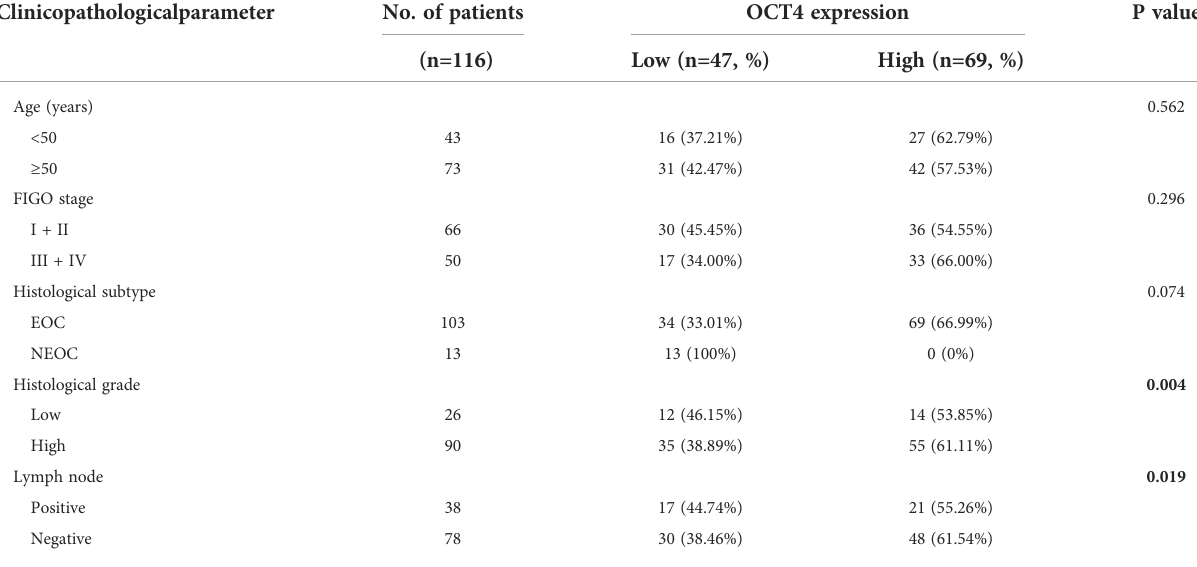
TABLE 1 Correlations between OCT4 expression and clinicopathologic parameters in 116 OC patients.